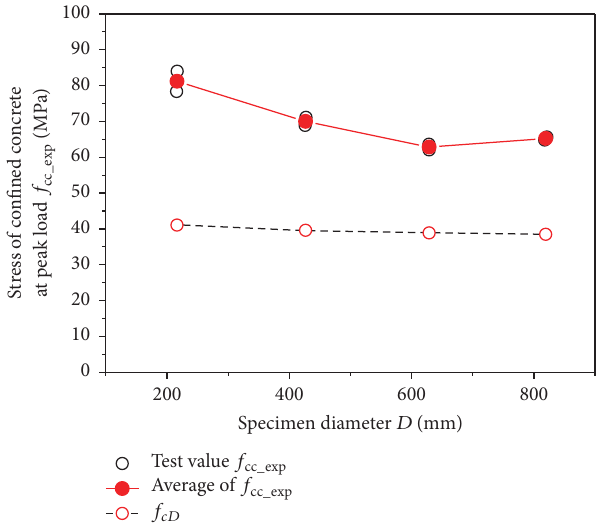
Figure 10: Relationship between strength of confined concrete and specimen size at moment of peak